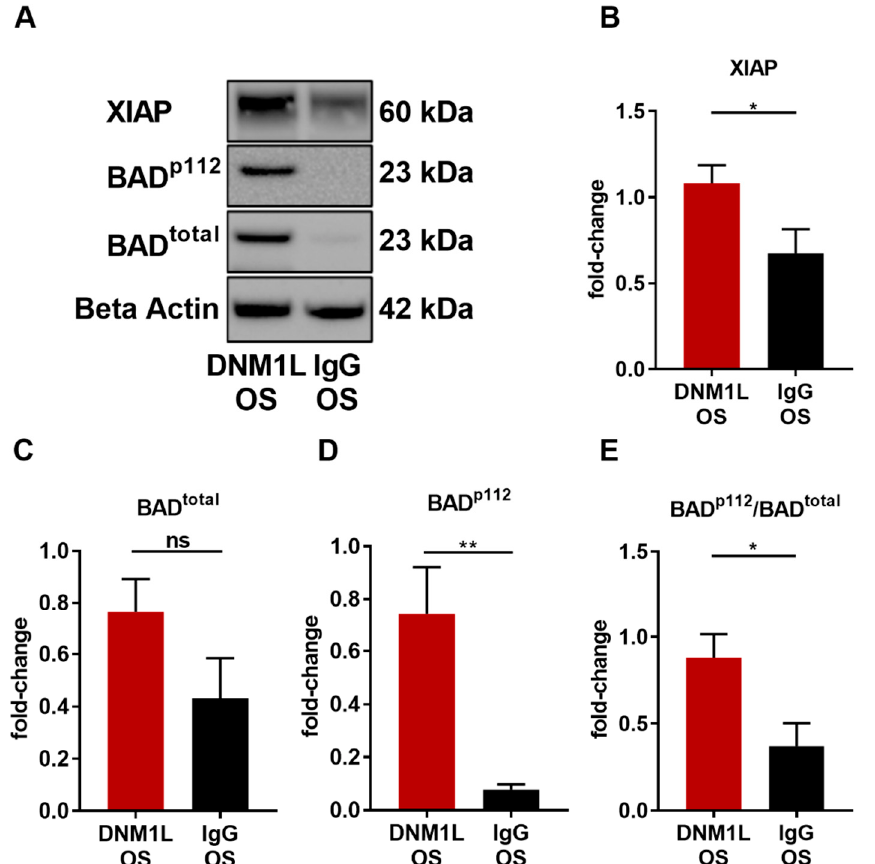
Figure 6. Anti-DNM1L Ab injection reduces proteins involved in mitochondrial apoptosis. ( A ) Western blot detection of XIAP, total protein expression of BAD (BAD total ), phosphorylation of BAD at serine 112 (BAD p112 ), and housekeeping protein beta-actin. The presented representative western blot is one of six biological replicates. Densitometric analysis of XIAP ( B ), BAD total ( C ), and BAD p112 ( D ). All calculated values were normalized to beta-actin. The ratio of BAD p112 /BAD total was calculated ( E ). All values are given as mean ± SEM calculated from six biological replicates. Statistical analysis was performed using student’s t -test. Significance level: * = p < 0.05, ** = p < 0.01, ns = not significant. Numbers of animals used: n = 6 (IgG), n = 6 DNM1L.